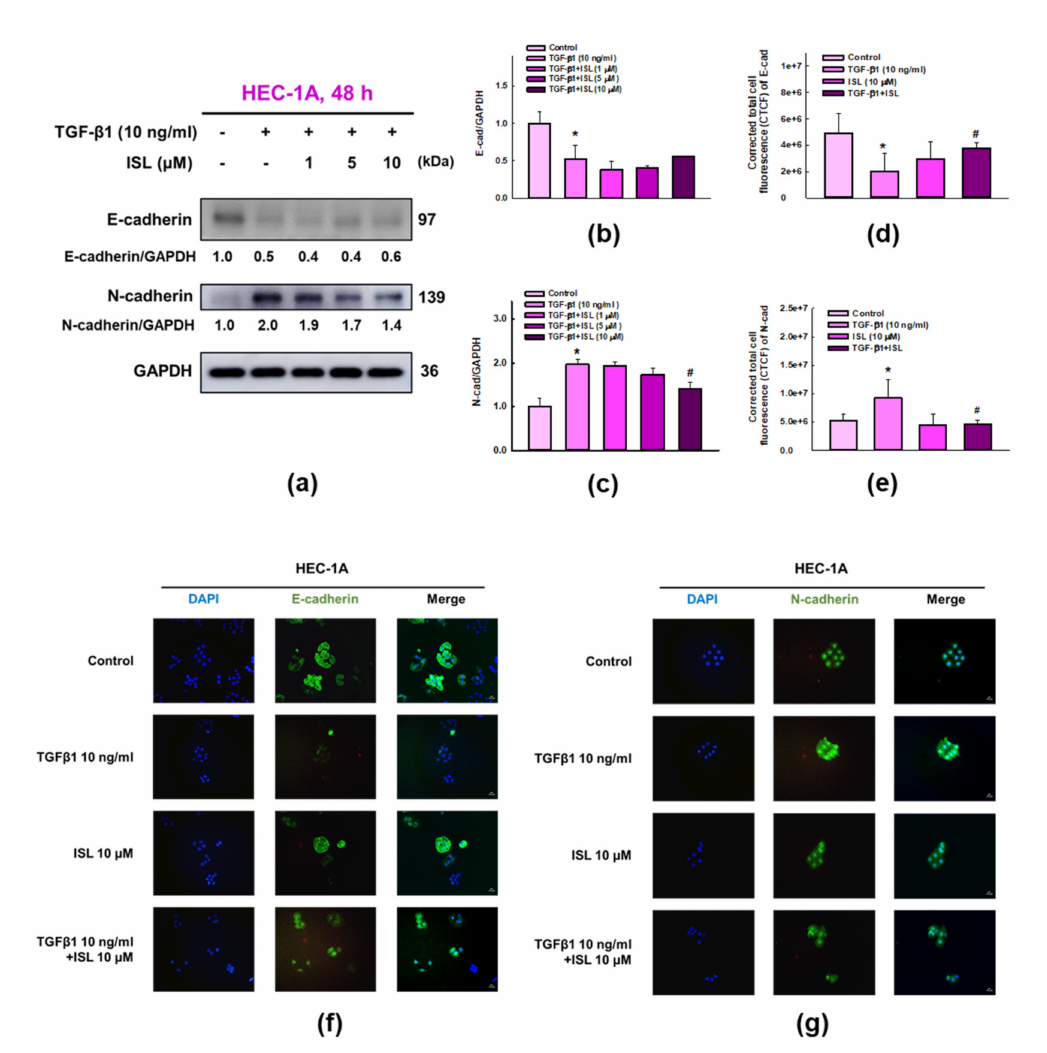
Figure 3. ISL reversed TGF- β 1-induced epithelial-mesenchymal transition (EMT) in human endometrial cancer HEC-1A cells. Cells were treated with 10 ng/mL of TGF- β 1 and ISL (1, 5, and 10 µ M) for 48 h. Cell lysates were separated by SDS-PAGE and subjected to western blotting with the anti-E-cadherin, and N-cadherin ( a ). Each target protein was normalized to GAPDH and protein quantification was shown in bar graph ( b , c ). Immunofluorescence staining in HEC-1A cells were monitored in the presence or absence of TGF- β 1 (10 ng/mL) and ISL (10 µ M). Green color represents the staining of E-cadherin ( f ) or N-cadherin ( g ). Blue color represents nuclear DNA staining by DAPI (600 × magnification). The corrected total cell fluorescence (CTCF) of E-cadherin ( d ) and N-cadherin ( e ) were quantified by ImageJ software. The quantitative values were expressed as the mean ± SD ( n = 3). * p < 0.05, versus the vehicle control. # p < 0.05, versus the TGF- β 1 alone